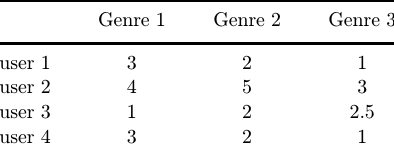
Table 6. Example of predicted genre ratings.